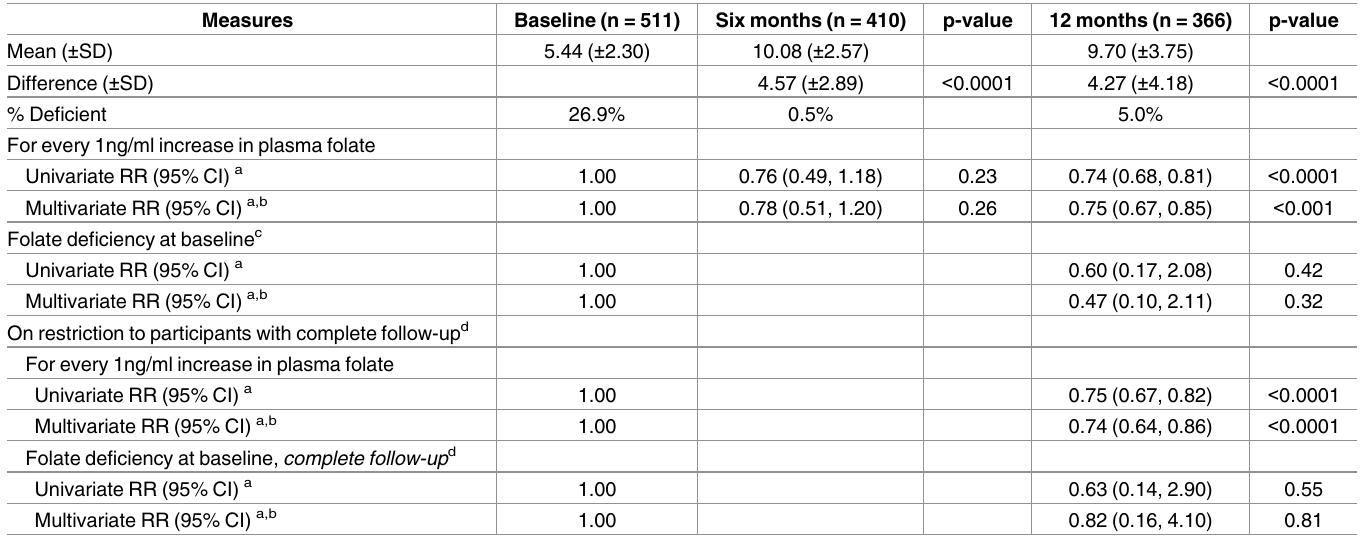
Table 4. Risk of folate deficiency among non-pregnant women of reproductive age in Dar es Salaam, Tanzania.